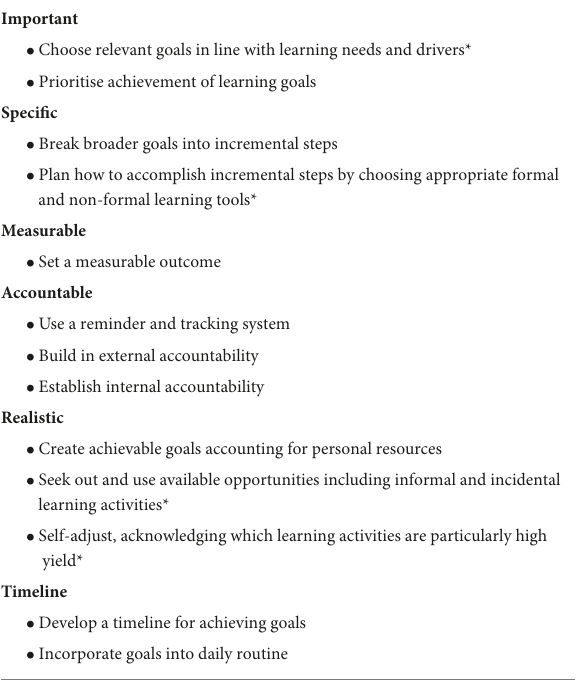
TABLE 4 A paradigm for achieving learning goals.